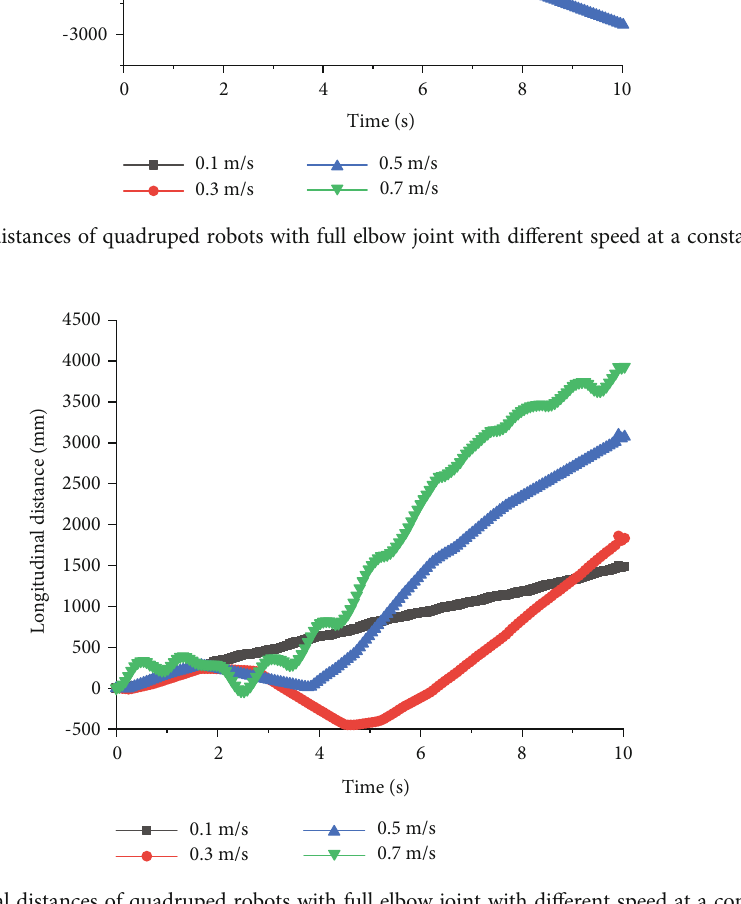
Figure 8: Longitudinal distances of quadruped robots with full elbow joint with di ff erent speed at a constant period.